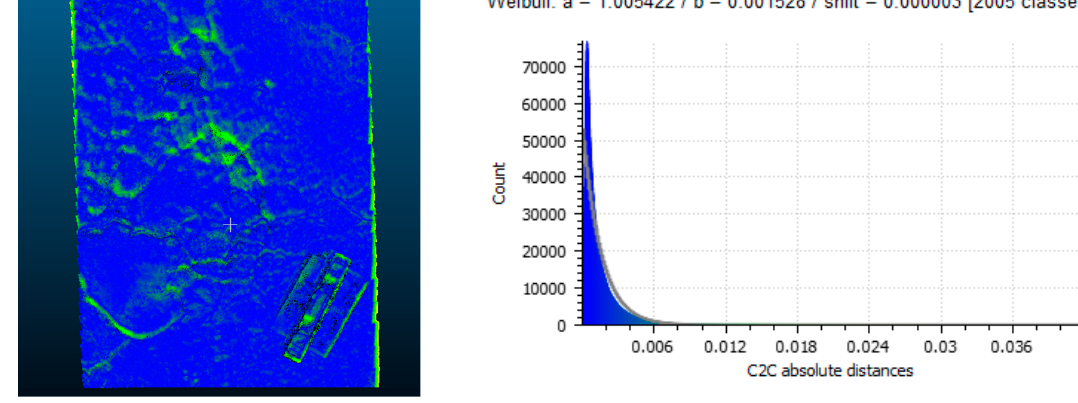
Figure 17. Measured differences between model generated by the camera and Samsung phone, ( right )—visualization of differences projected on model, ( left )—distribution of measured differences.